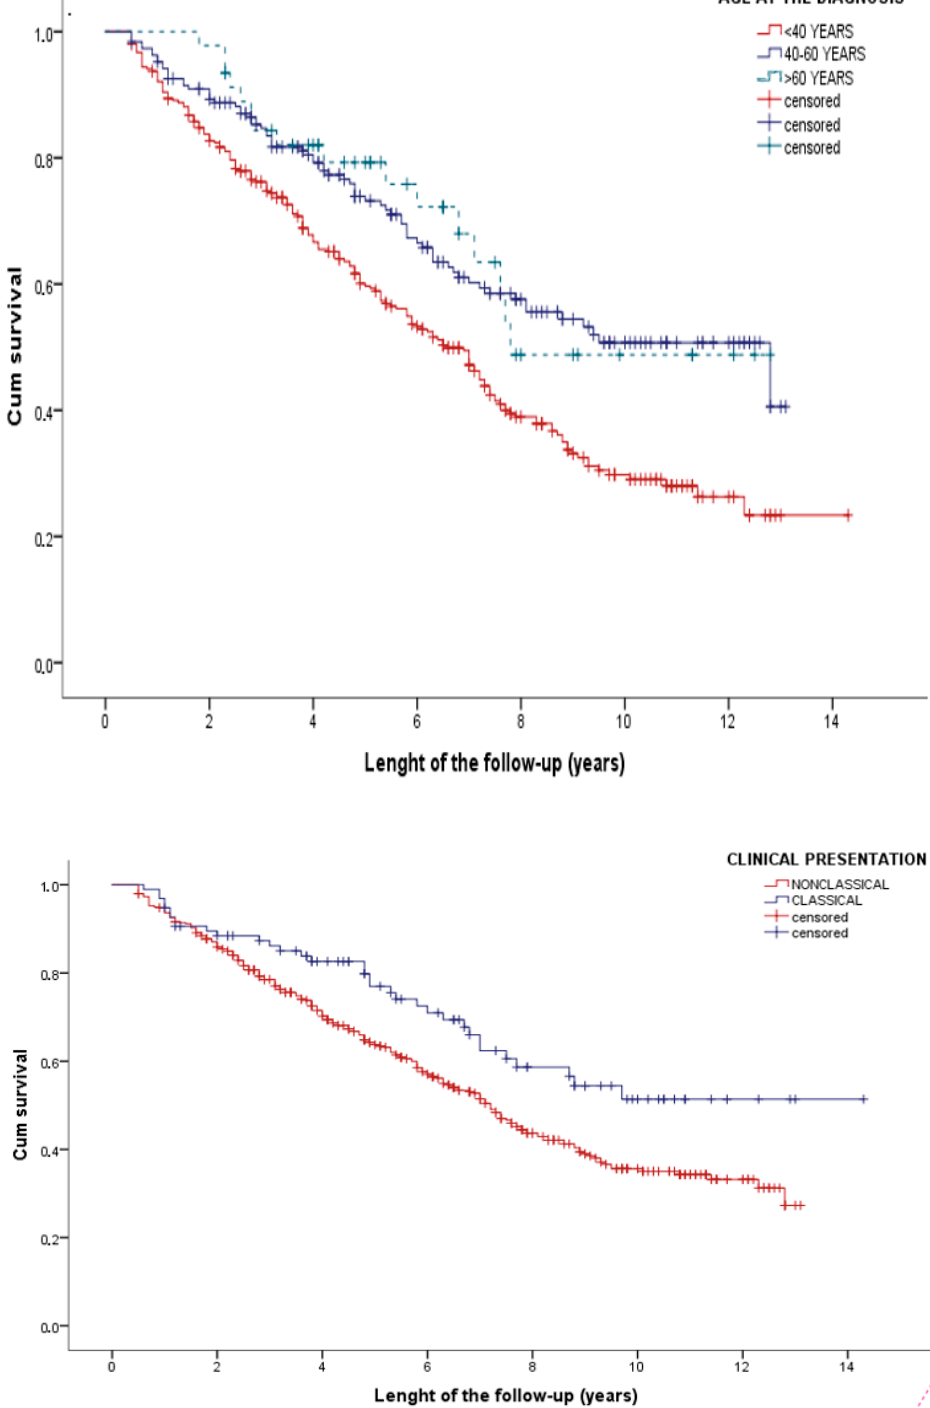
Figure 3. Time to drop-out stratified according to ( above ) age at diagnosis; ( below ) clinical presentation of celiac disease.